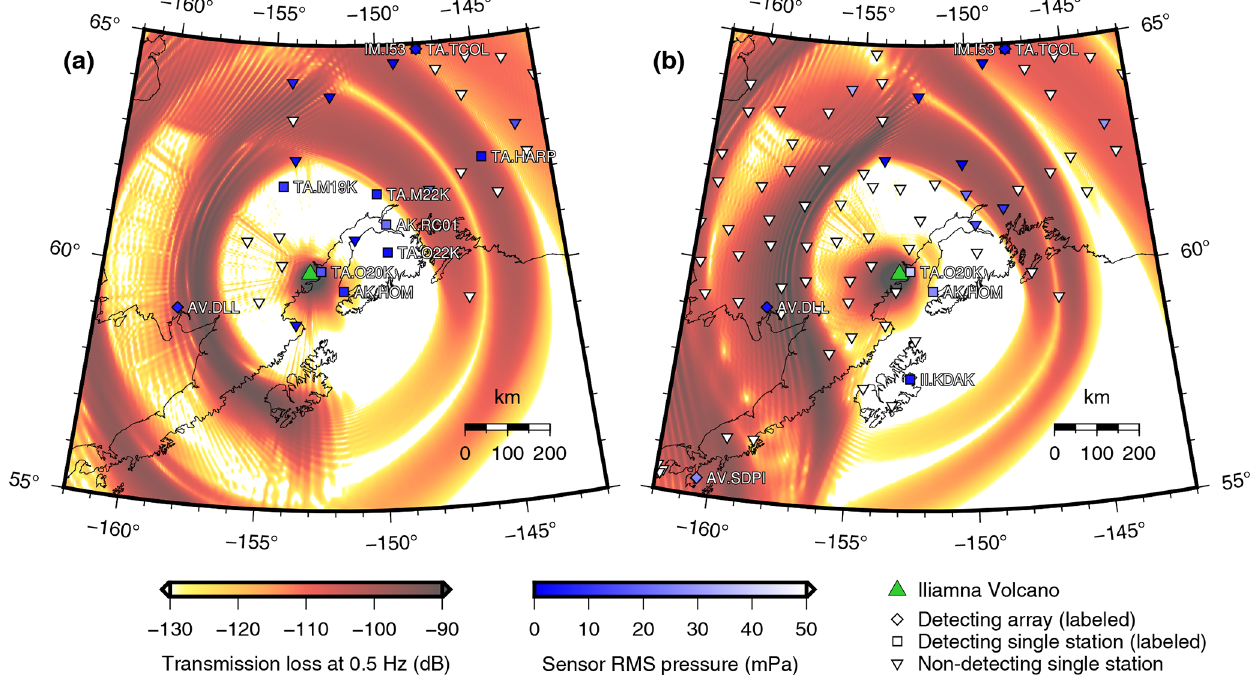
Figure 6. Acoustic transmission loss at the Earth’s surface, modeled at 0.5Hz for the (a) 2016 and (b) 2019 avalanches. The atmospheric model is a single sonde (1D atmospheric profile) over the avalanche path midpoint. Iliamna Volcano is indicated by the green triangle. Diamonds and squares denote the respective arrays and stations where the avalanche signal was detected. Inverted triangles indicate other infrasound stations where no signal was observed. The blue shades on the station markers indicate root-mean-square (RMS) pressure in the 0.5–2Hz band for hour-long windows prior to the predicted true arrival. This is a proxy for local site noise. (See Sect. 3 for description of network codes.)